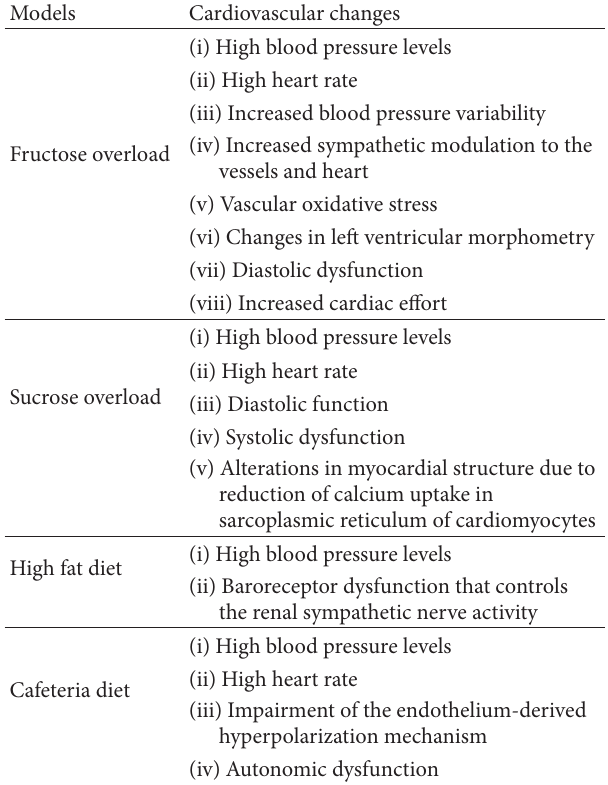
Table2:Maincardiovascularfindingsinchemicallyinducedanimal models of metabolic syndrome.